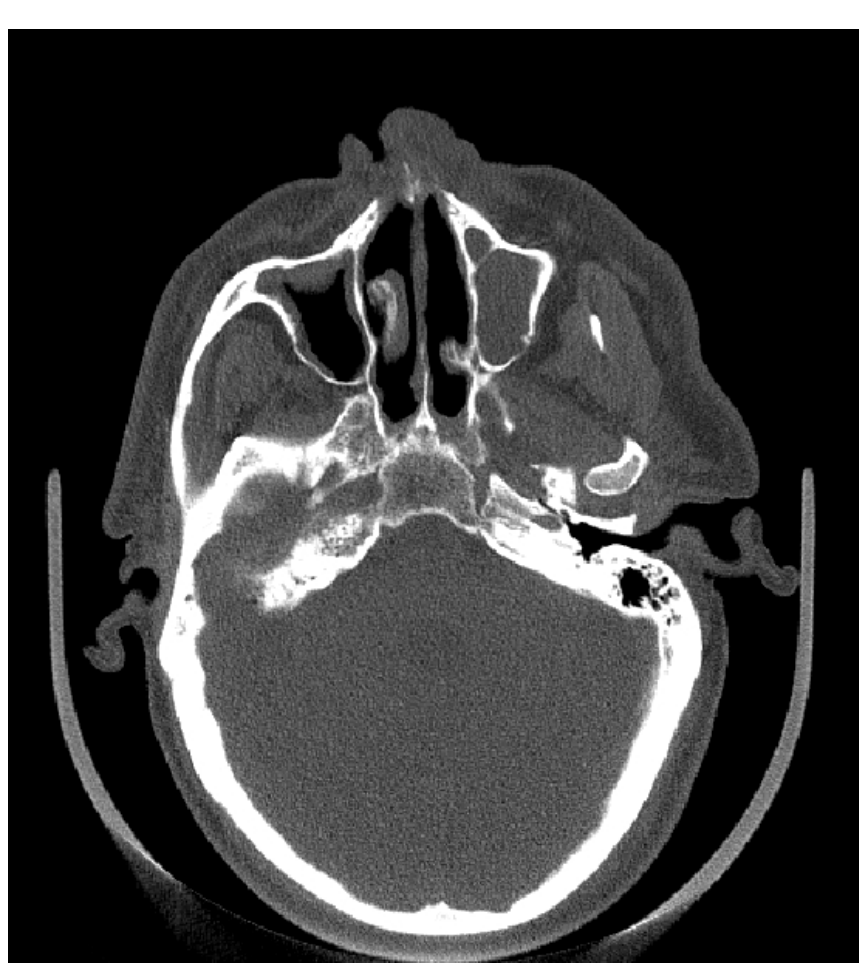
Fig. 8 Axial CT scan of the head. The left auricle is deformed by the